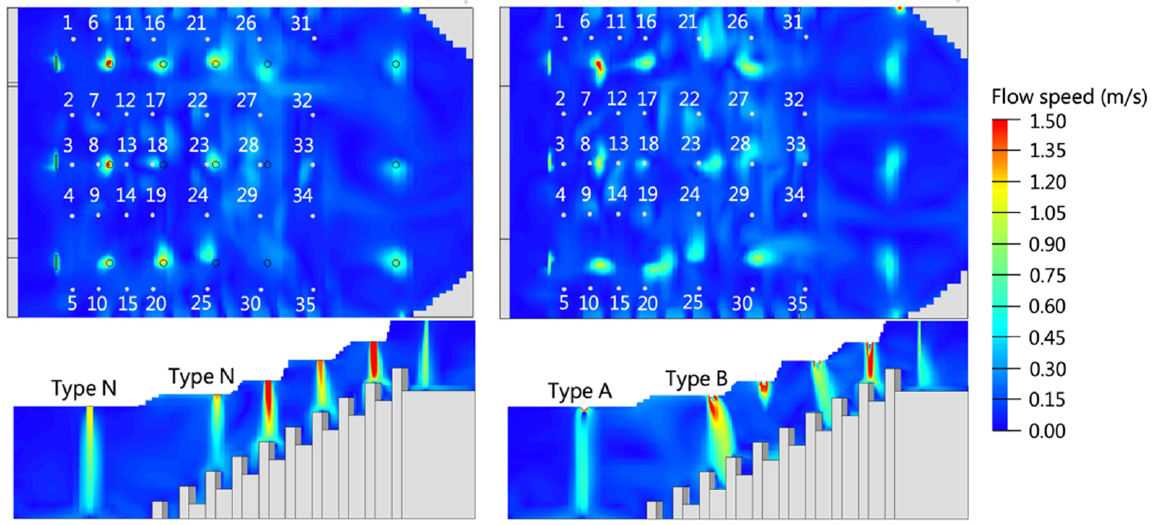
Figure 15. Air velocity distribution of scheme one and two.